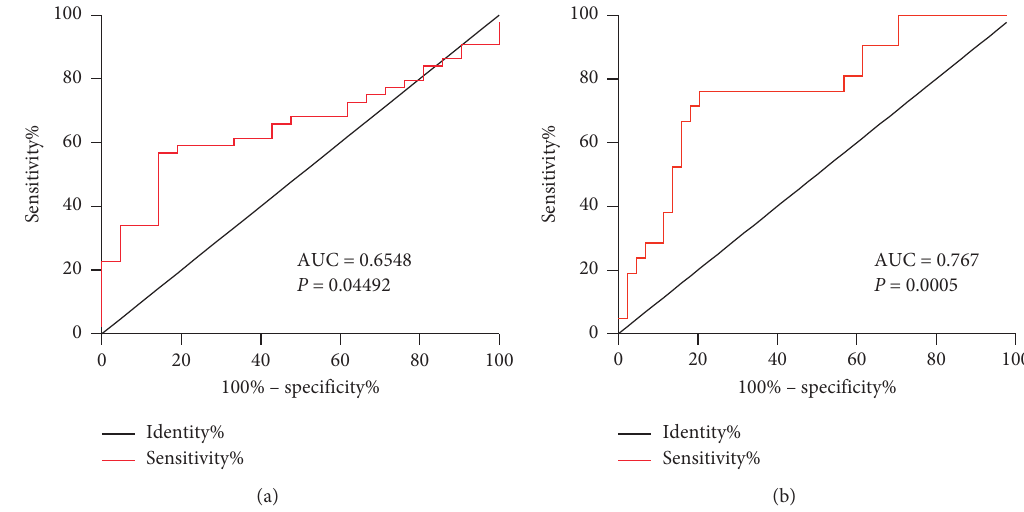
Figure 4: The diagnostic power of plasma choline in SCF. (a) Receiver operating characteristic (ROC) curve analysis of plasma choline level in patients with NCF and SCF. (b) Receiver operating characteristic (ROC) curve analysis of plasma choline level in patients with NCF and SCF after adjustment with sex, drinking, and white blood cell numbers. AUC, area under the curve.